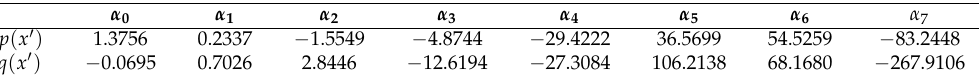
Table 1. Curve-fit polynomial coefficients for Equation (27) which generate the traction distributions in Figure 8.